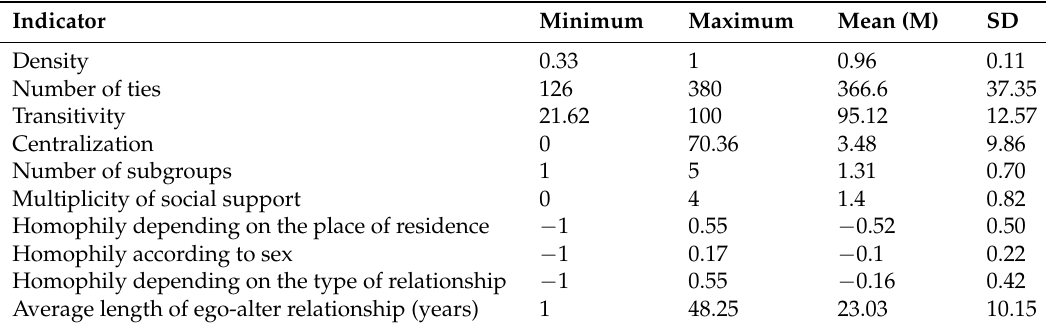
Table 1. Structural indicators of personal networks ( n =